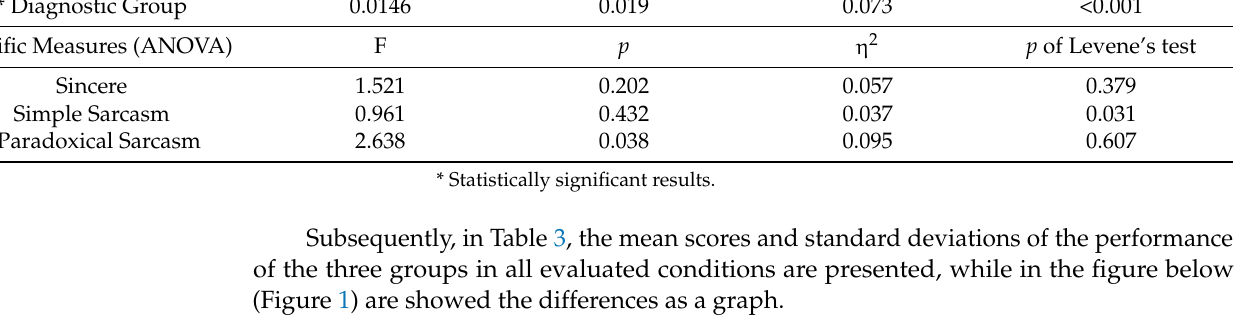
Table 3. Mean scores and standard deviations of three groups in TASIT scenes (* p < 0